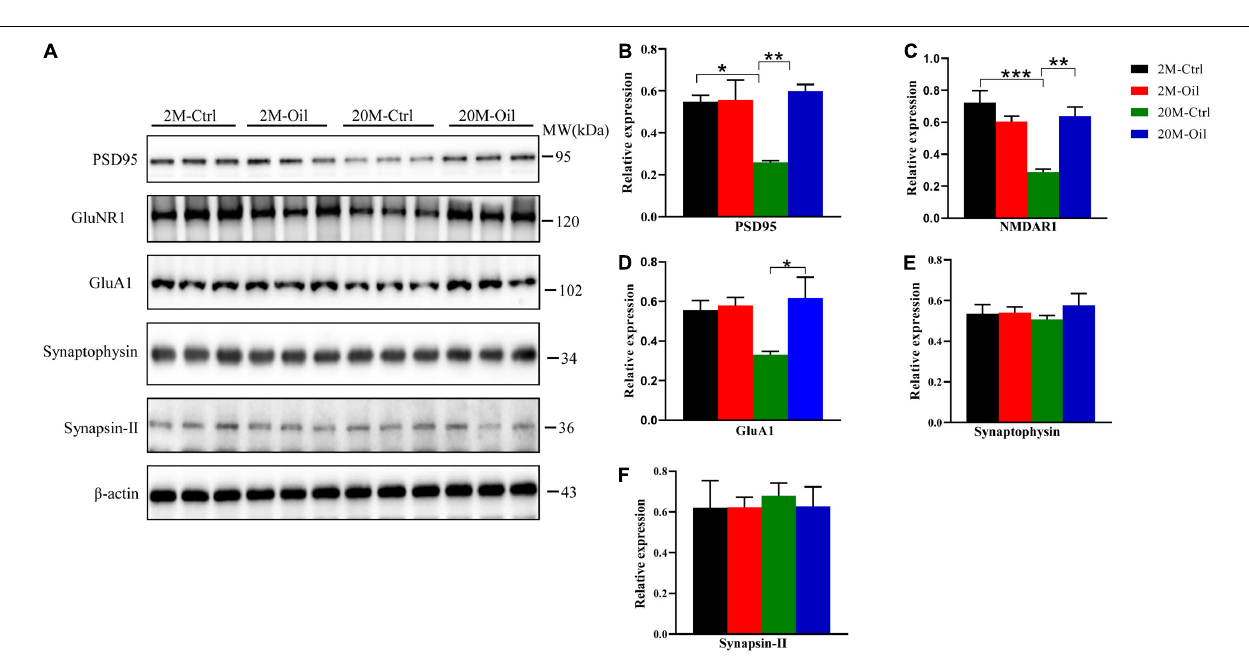
Frontiers in Cell and Developmental Biology |